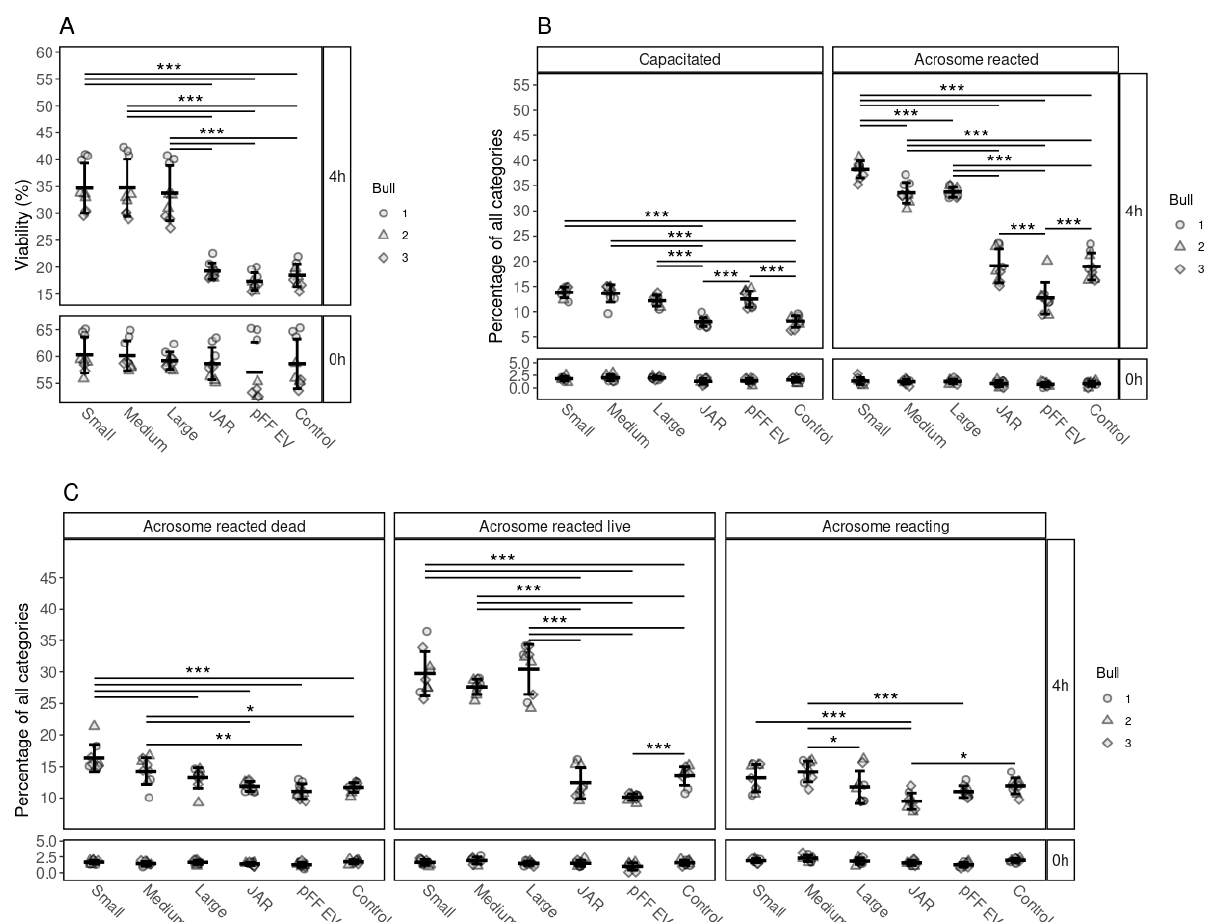
Figure 4. The effects of supplementation of EVs from different cellular sources on the viability, capacitation and acrosomal reaction of spermatozoa. ( A ) Percentages of live spermatozoa 0 and 4 h after supplementation with EVs from small, medium and large follicles, JAr EVs, pFF EVs and control. ( B ) Percentages of spermatozoa at different stages of capacitation reaction 0 and 4 h after supplementation with EVs from different sources. ( C ) Percentages of spermatozoa at different stages of the acrosomal reaction after supplementation with EV from different sources at 0 and 4 h. Error bars display the mean ± standard deviation (SD). Different symbols represent measurements of samples from different bulls. Asterisks mark statistically significant differences between the supplementation groups and relate to p -values as follows: * p ≤ 0.05; ** p ≤ 0.01; *** p ≤ 0.001. Double lines annotate p -values of the same category. In that case, asterisks above the top line also apply to the bottom line. The ends of the lines mark the groups that were contrasted.